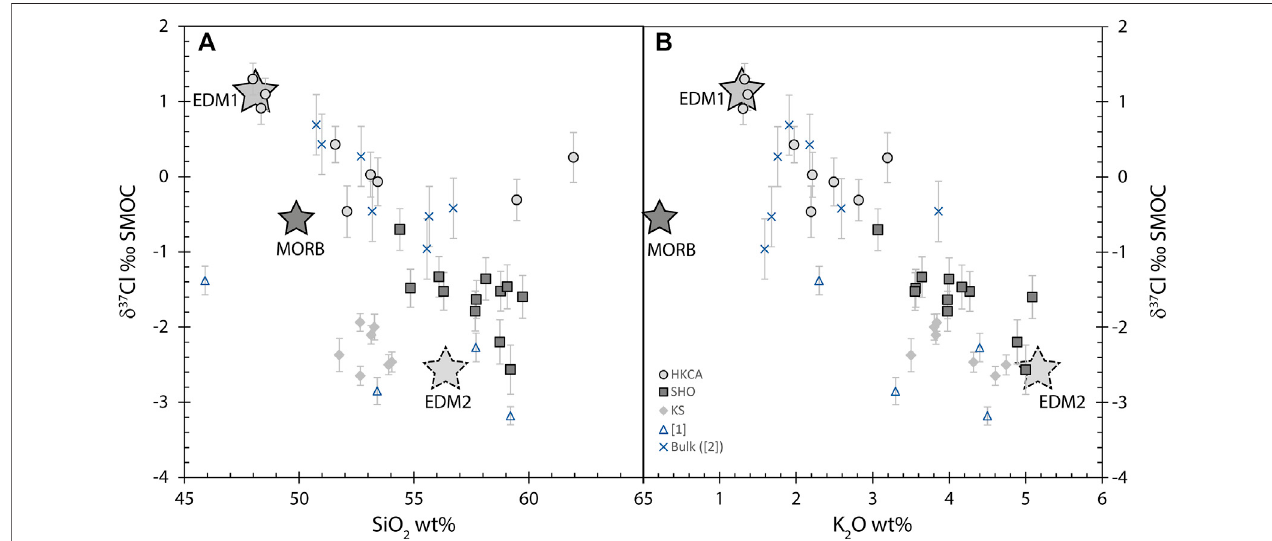
FIGURE 7 | Chlorine isotopes plotted against SiO 2 (A) and K 2 O (B) content of melt inclusions. For comparison, average MORB composition is plotted (dark star: Hofmann, 1988; Sharp et al., 2010). Only high potassium calco alkaline melt inclusions have similar composition to bulk rocks on these two plots. A positive correlation can be seen between δ 37 Cl and K 2 O, whereas there is no correlation with SiO 2 . Two main Cl endmembers (EDM1 and EDM2) are plotted and discussed in the text.